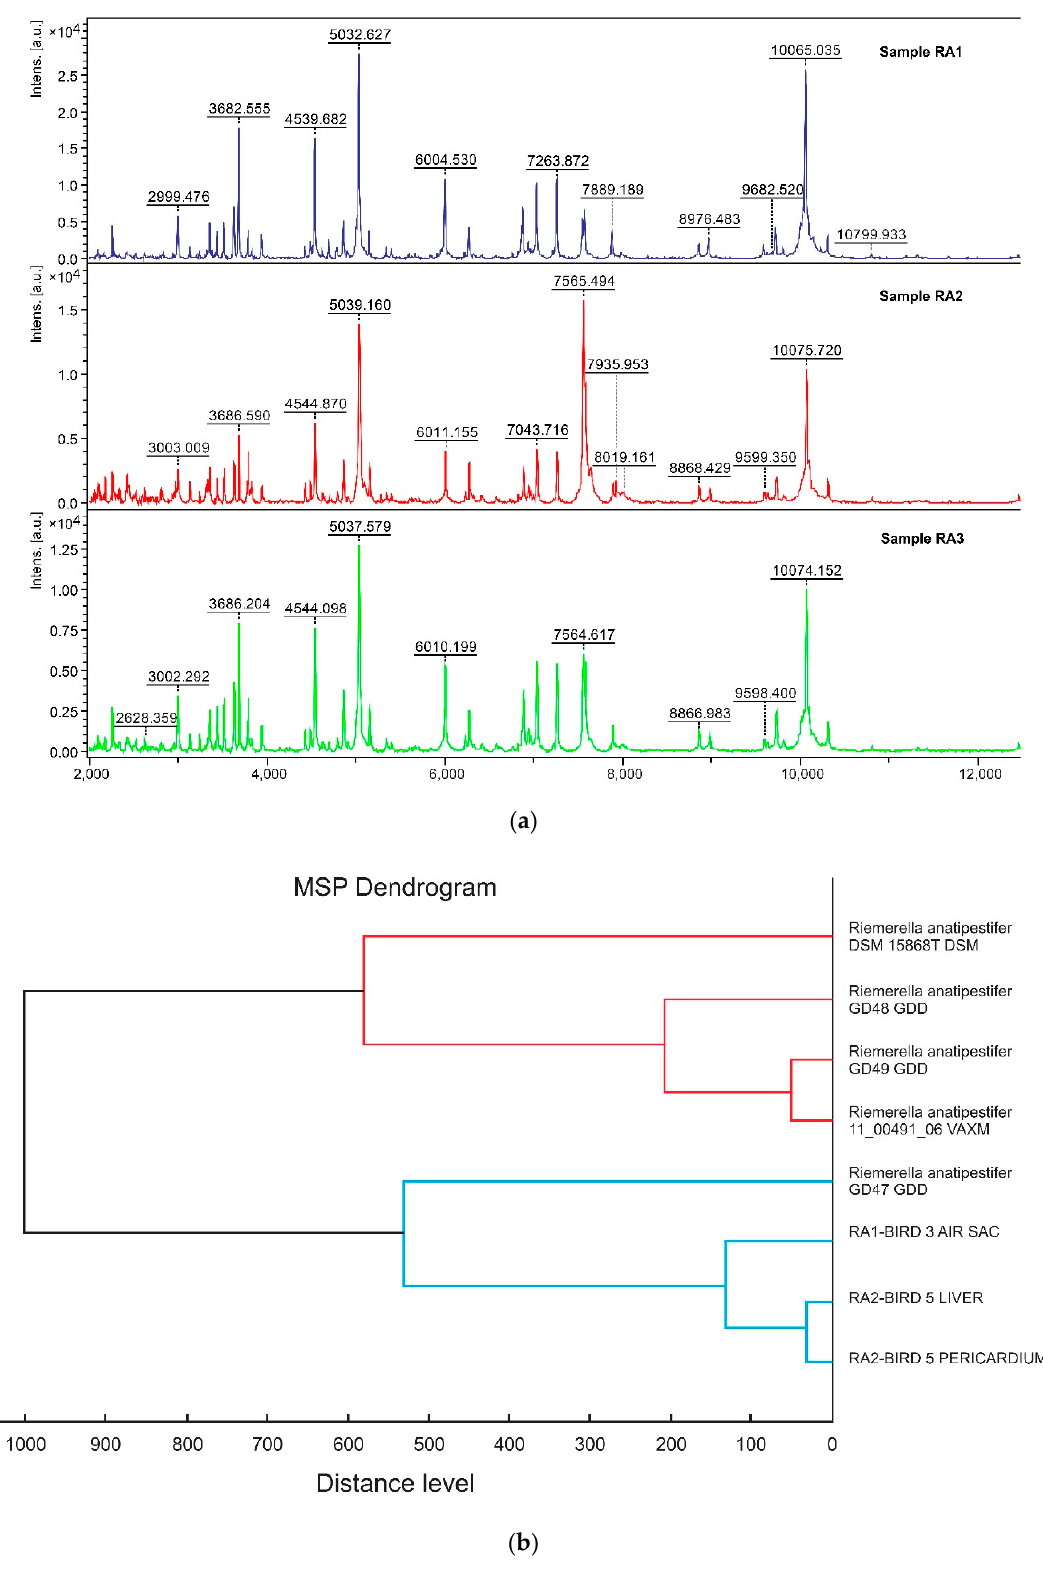
Figure 2. ( a ) Mass spectra for Riemerella anatipestifer (RA) isolates, analyzed by MALDI-TOF MS; ( b ) MSP dendrogram: Classification of three isolates of Riemerella anatipestifer , based on the protein mass patterns, analyzed by MALDI Biotyper software using MALDI-TOF MS.